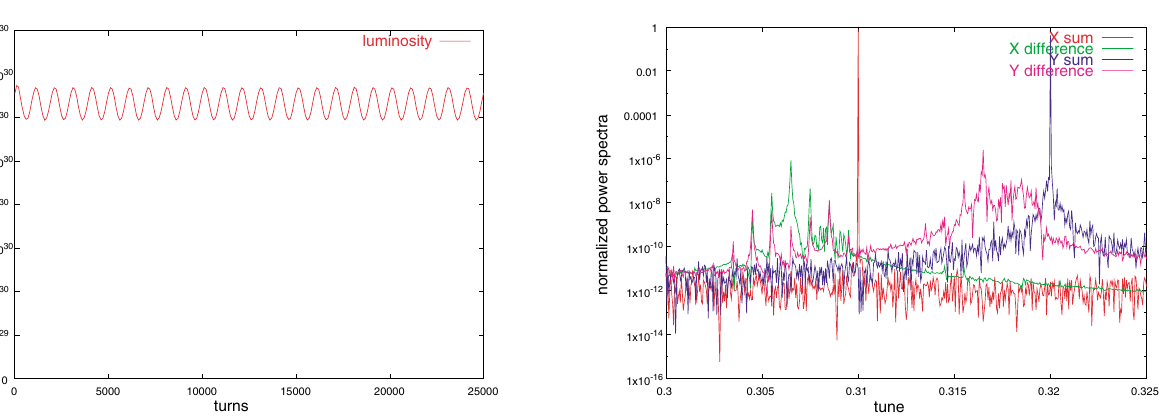
FIG. 9. (Color) Spectra of the sum and difference centroid motion during the sweeping